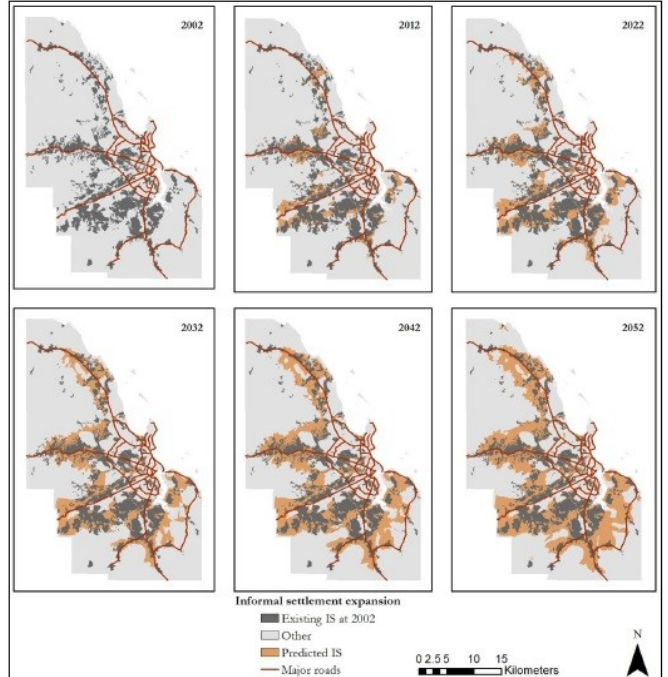
Figure 2. Projected informal settlement expansion in Dar es Salaam (2002—2052). Source: Abebe (2011).